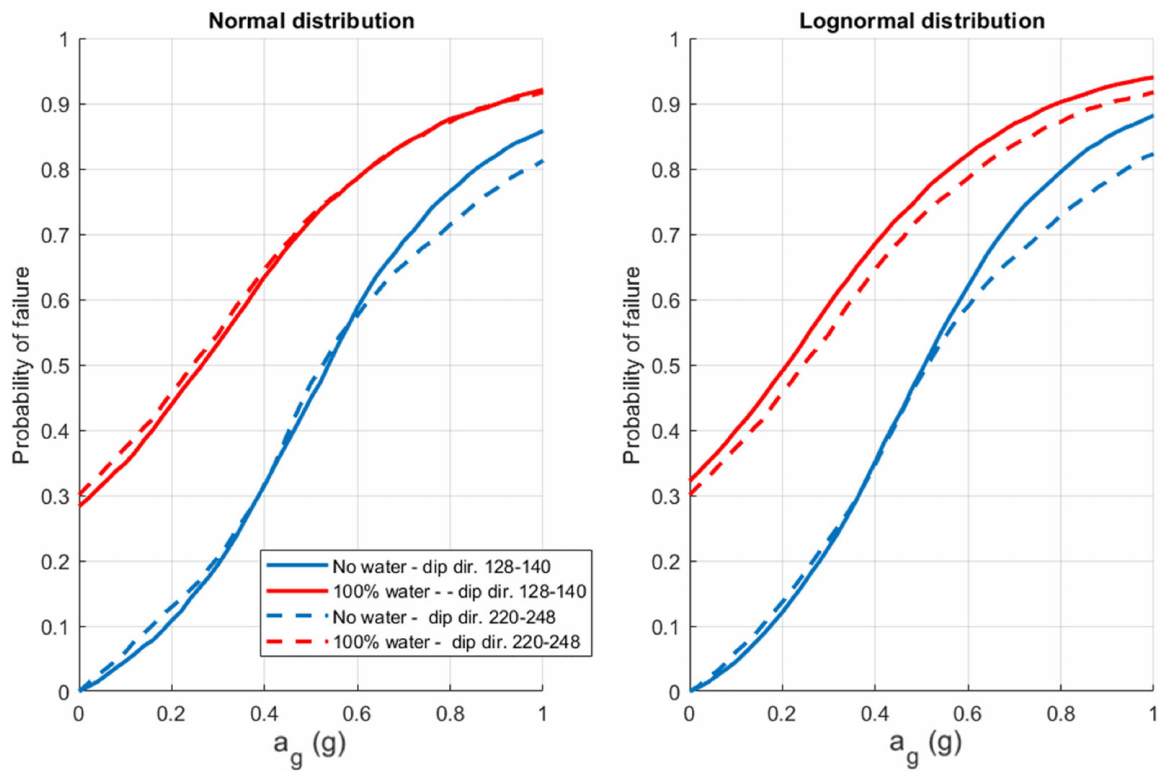
Figure 13. Comparison between fragility curves for wedge sliding at different slope dip directions assuming normal distribution ( left ) and lognormal distribution ( right ) for the controlling